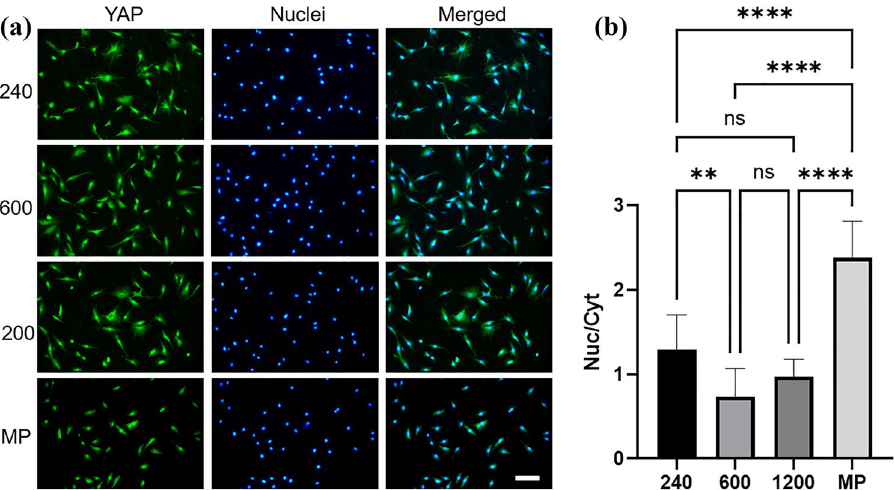
Figure 4. YAP distribution of cells cultured on Ti with disordered abrasive scratches. Fluorescent microscopic images of YAP ( a ) and its distribution of nucleus to cytoplasm ratio ( b ). The scale bar indicated 100 μm, and the data shown are mean ± SD. **p < 0.01; ****p < 0.001. ns indicates no significant